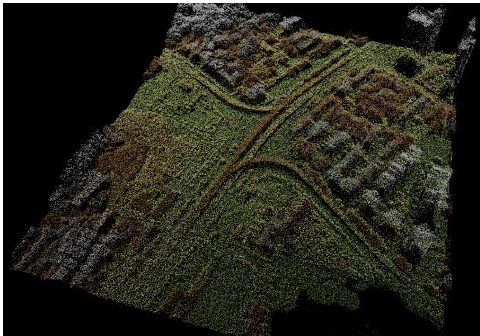
Figure 2. Point cloud of Zhuodaoquan